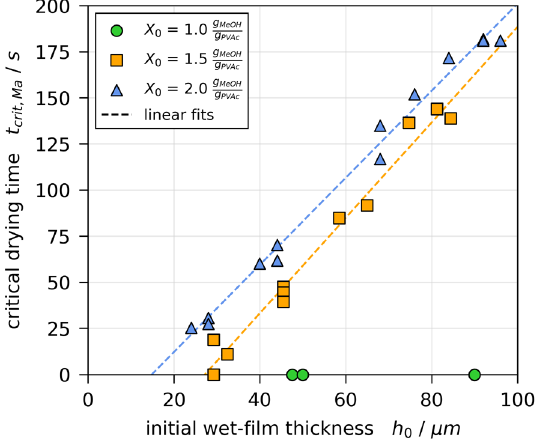
Figure 10. Critical drying times t crit , Ma , denoting the transition from convectively unstable to stable during 3D- µ PTV drying experiments, plotted over initial wet film thickness h 0 from Figure